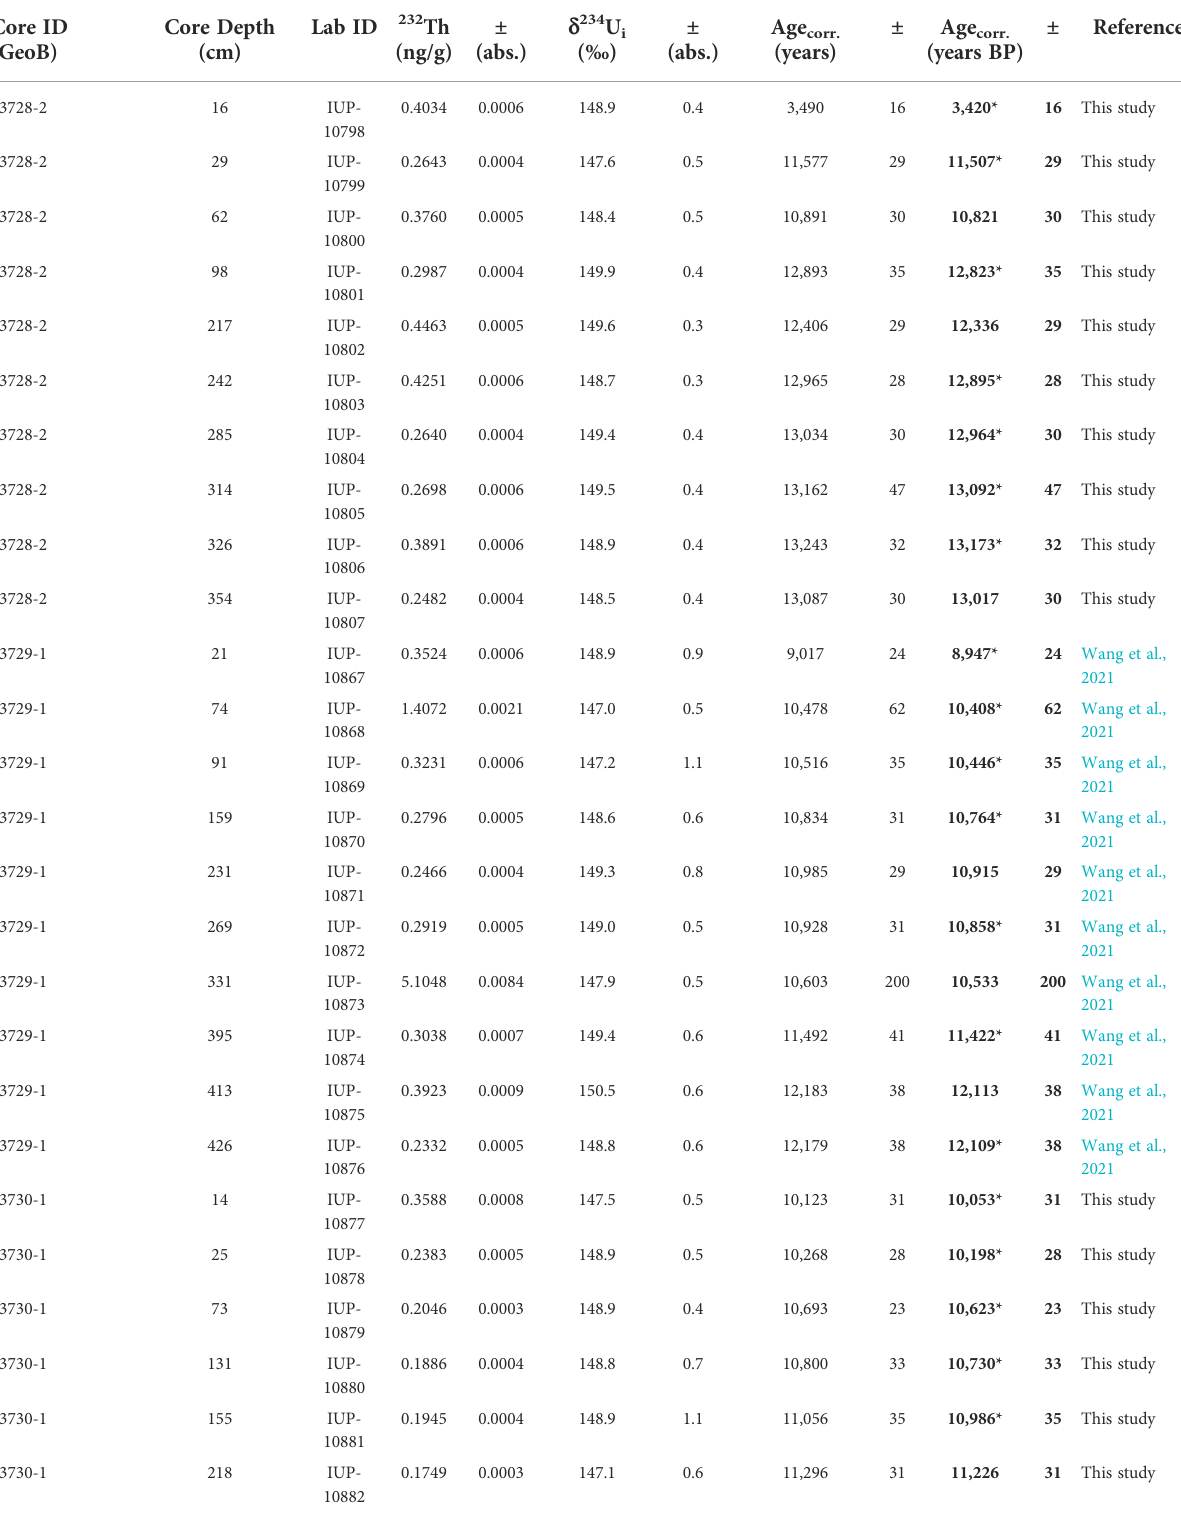
TABLE 1 U/Th dates and uranium and thorium isotope concentrations and ratios obtained from cold-water coral fragments ( Desmophyllum pertusum ) collected from sediment cores GeoB13728-2, GeoB13729-1, and